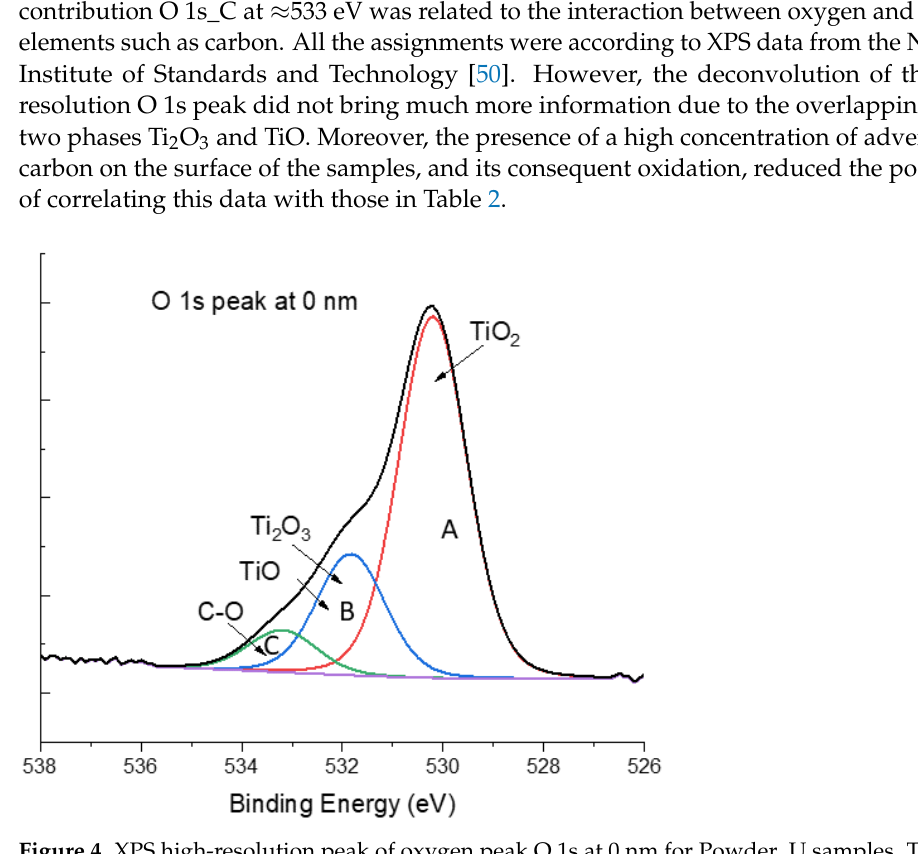
Figure 4. XPS high-resolution peak of oxygen peak O 1s at 0 nm for Powder_U samples. The three major contributions are O 1s_A, O 1s_B, and O 1s_C.